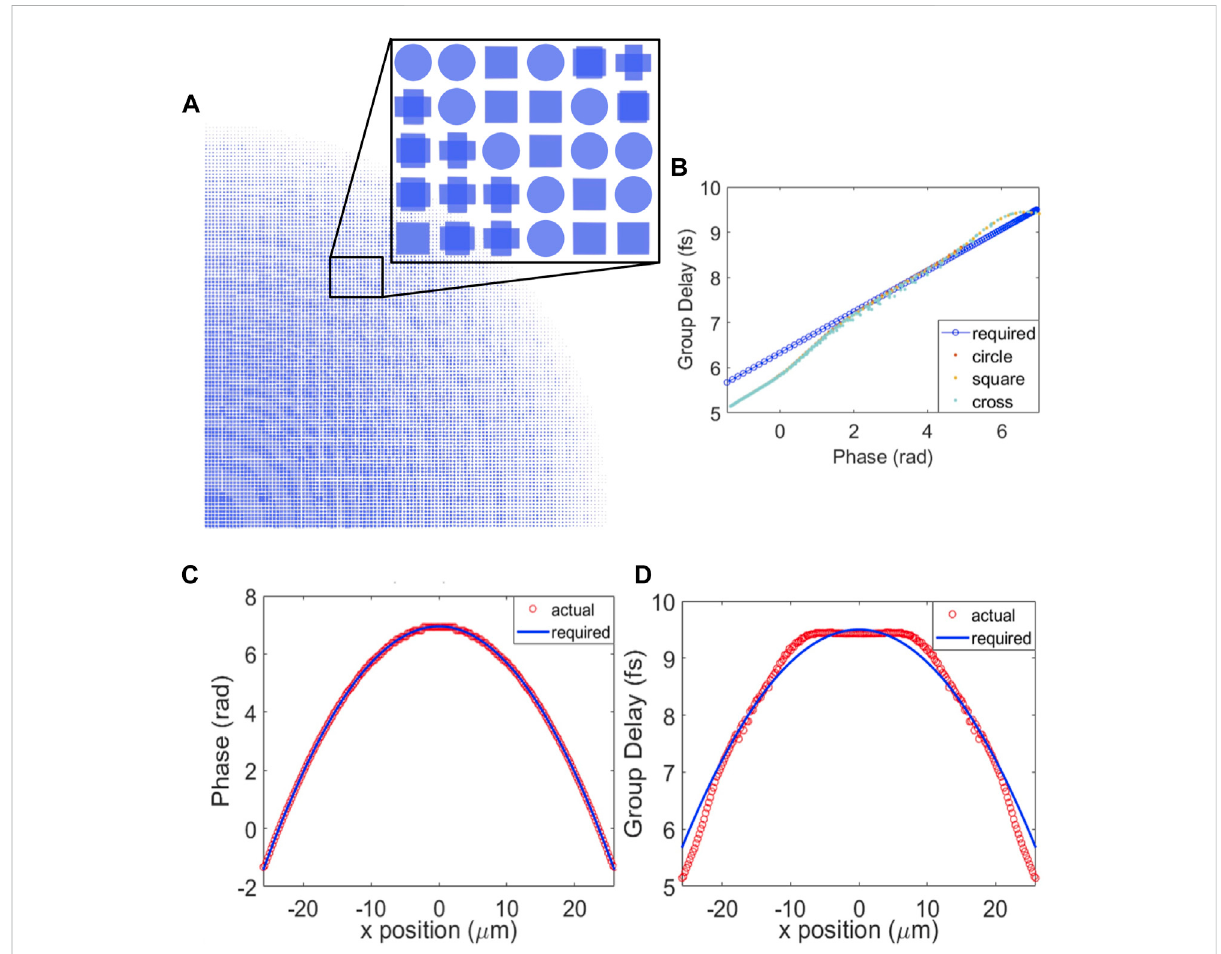
FIGURE 3 Design for 810 – 910 nm achromatic on-axis metalens. (A) Top view of the upper right quarter of achromatic metalens and cross-sections of nanopillars. (B) Group delay vs. phase plot for achromatic metalens - Required group delay vs. phase for each radial position and simulated